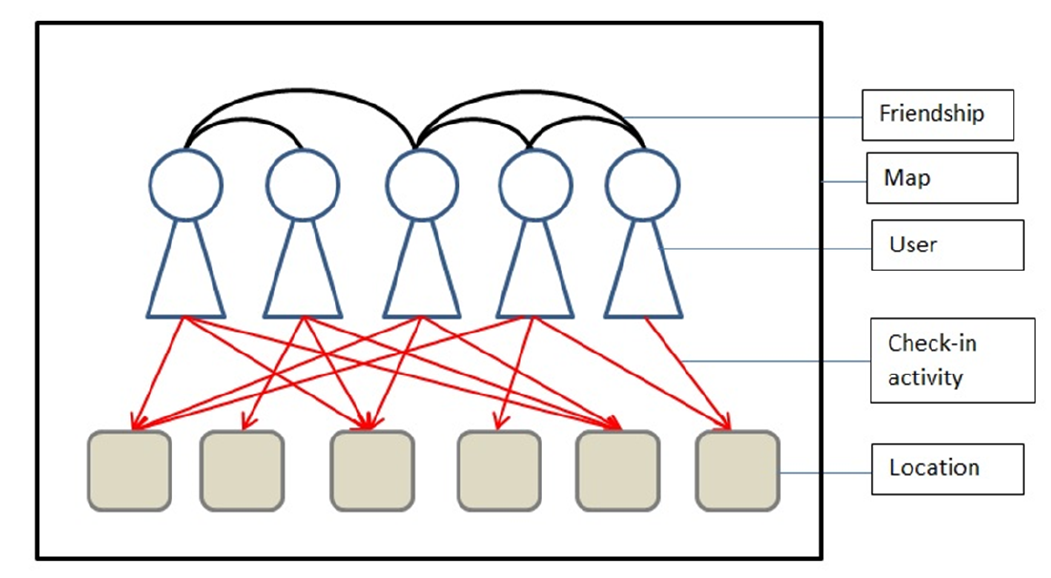
Figure 1. A graph of friends’ check-in activity in a location-based recommender